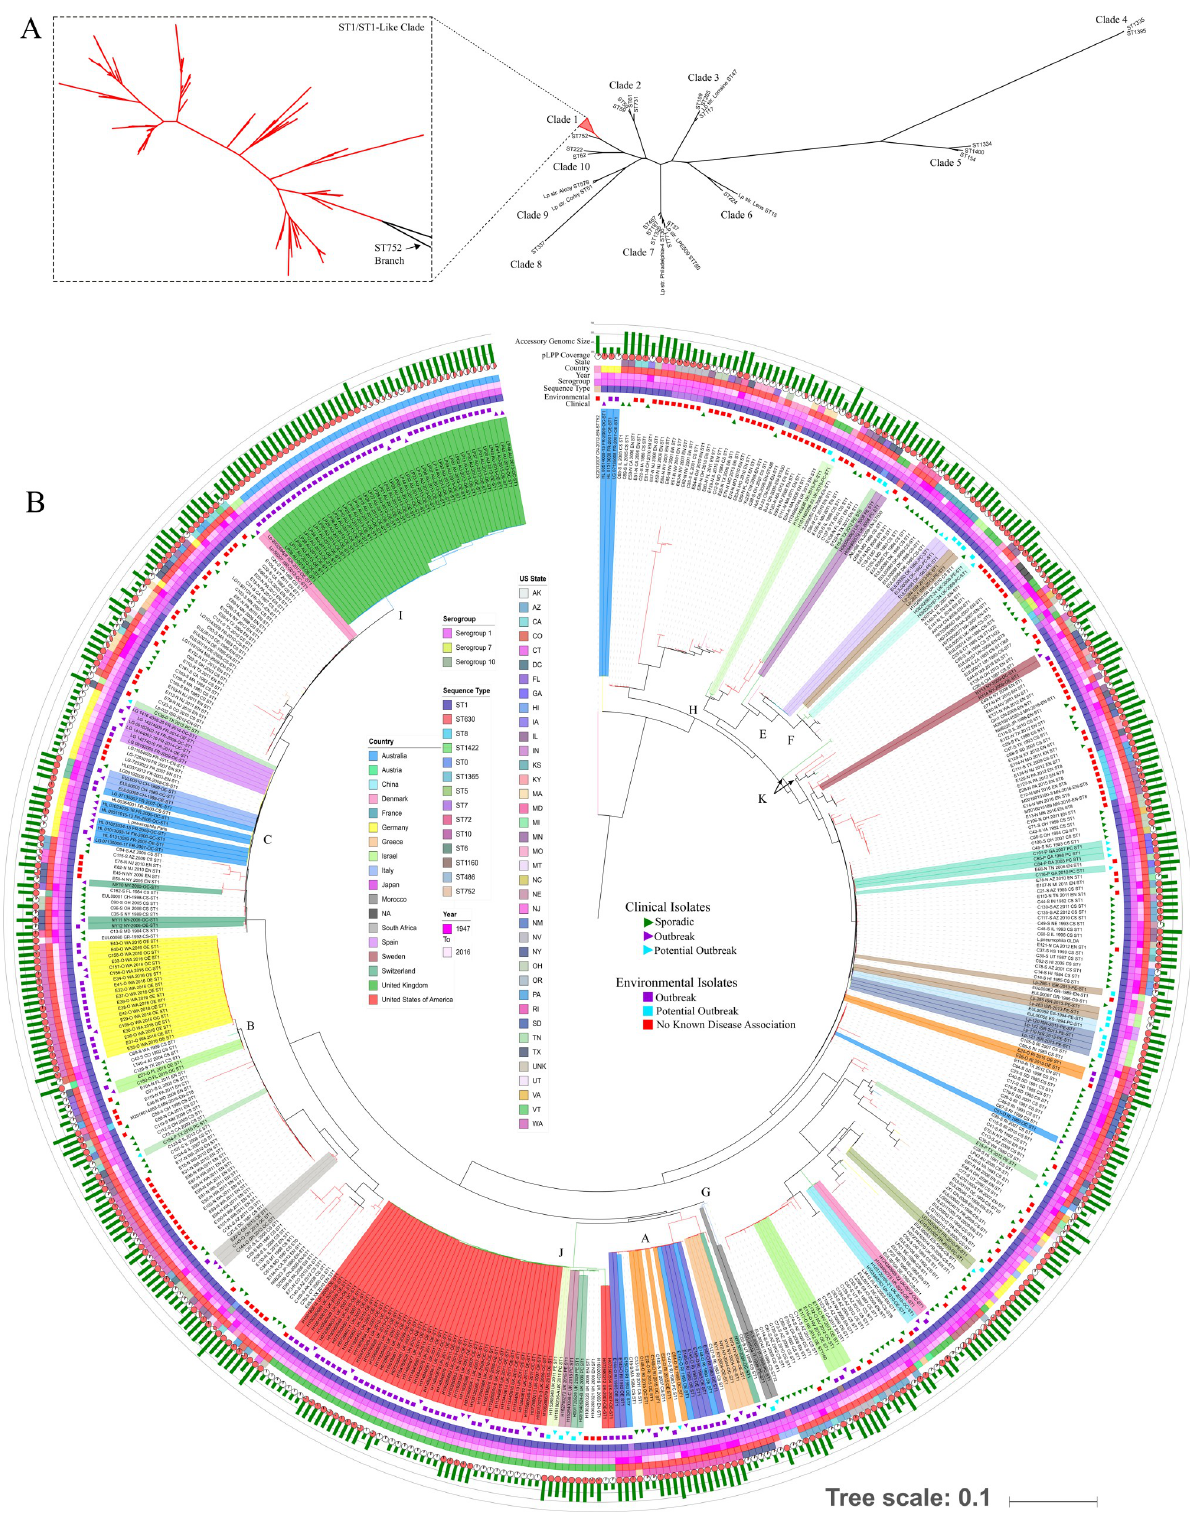
Fig 4. Whole genome SNP-based phylogenetic comparisons of ST1 and ST1-like isolates in the current dataset. A ) Unrooted tree of 28 different L . pneumophila sequence types, including the ST1 clade (collapsed red triangle) alongside an international ST752 double locus variant of ST1. Clade numbers are discussed in the text. Isolate ID’s for each ST are defined in the ‘Comments’ column of S1 Table. B ) All-SNP-based phylogenetic tree of